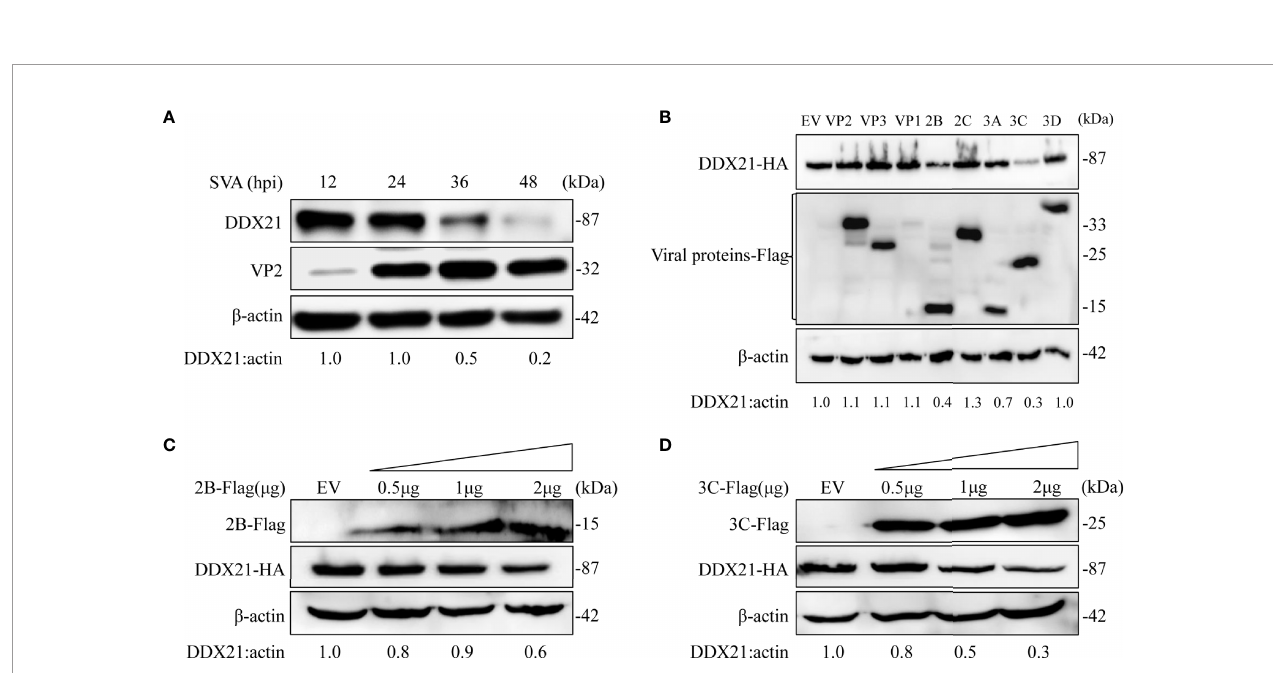
FIGURE 4 | SVA degrades endogenous DDX21 during viral infection, and DDX21 is degraded by SVA 2B and 3C. (A) BHK-21 cells in 6-well plates were infected with SVA at a MOI of 0.1, cells were harvested at indicated times, and the expression level of endogenous DDX21 protein was analyzed by WB. (B) HEK293T cells in six-well plates were cotransfected with HA-DDX21 and Flag-VP1, VP2, VP3, 2B, 2C, 3A, 3C, or 3D, cells were harvested at 30 h, and the samples were analyzed by WB. (C, D) HEK293T cells were cotransfected with HA-DDX21 and different concentrations of Flag-2B or Flag-3C for 30 h. The cell lysates were analyzed by